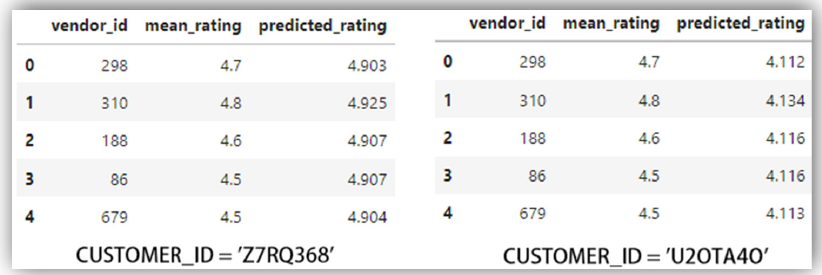
Figure 38. Start the server and client systems.